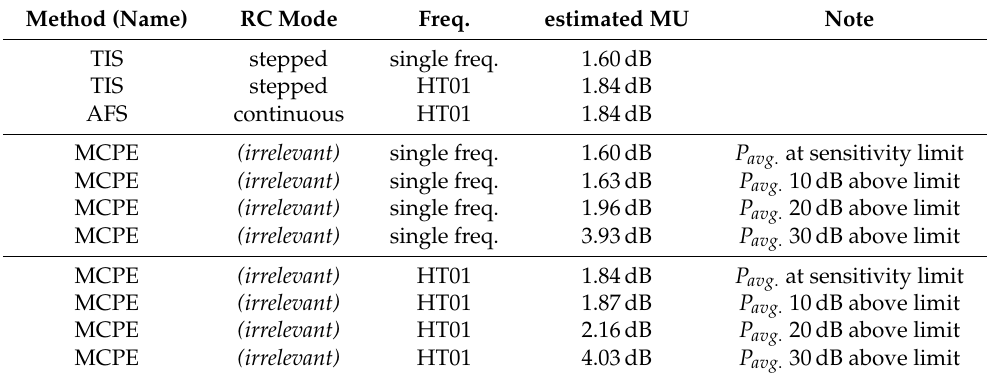
Table 8. Overview of estimated, total expanded measurement uncertainties for different sensitivity measurement methods (each includes a coverage factor of